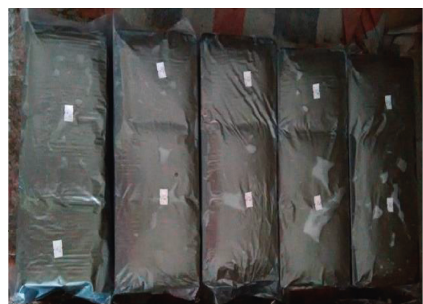
Figure 2: Test blocks.